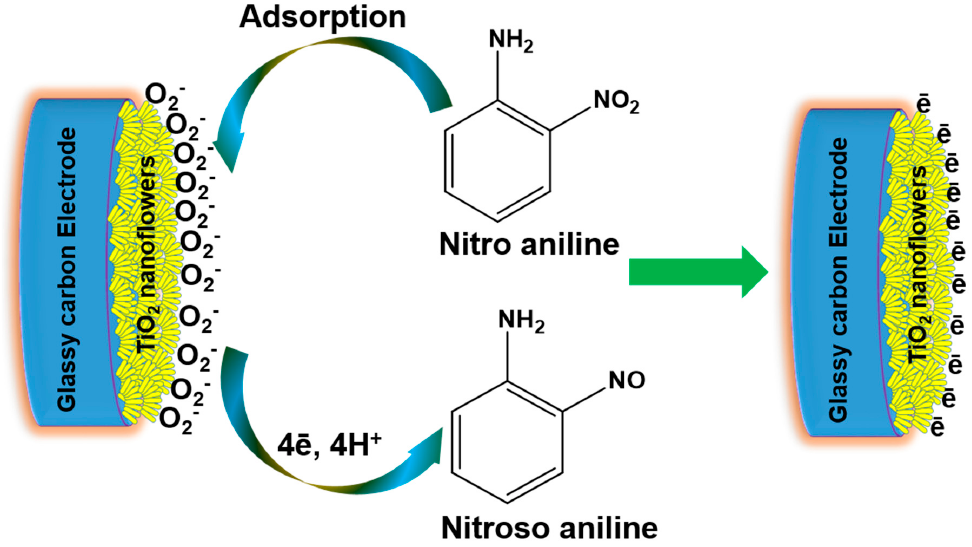
Figure 9. Illustration of possible nitroaniline chemical sensing over TiO 2 nanoflowers-modified glassy carbon electrode (GCE).